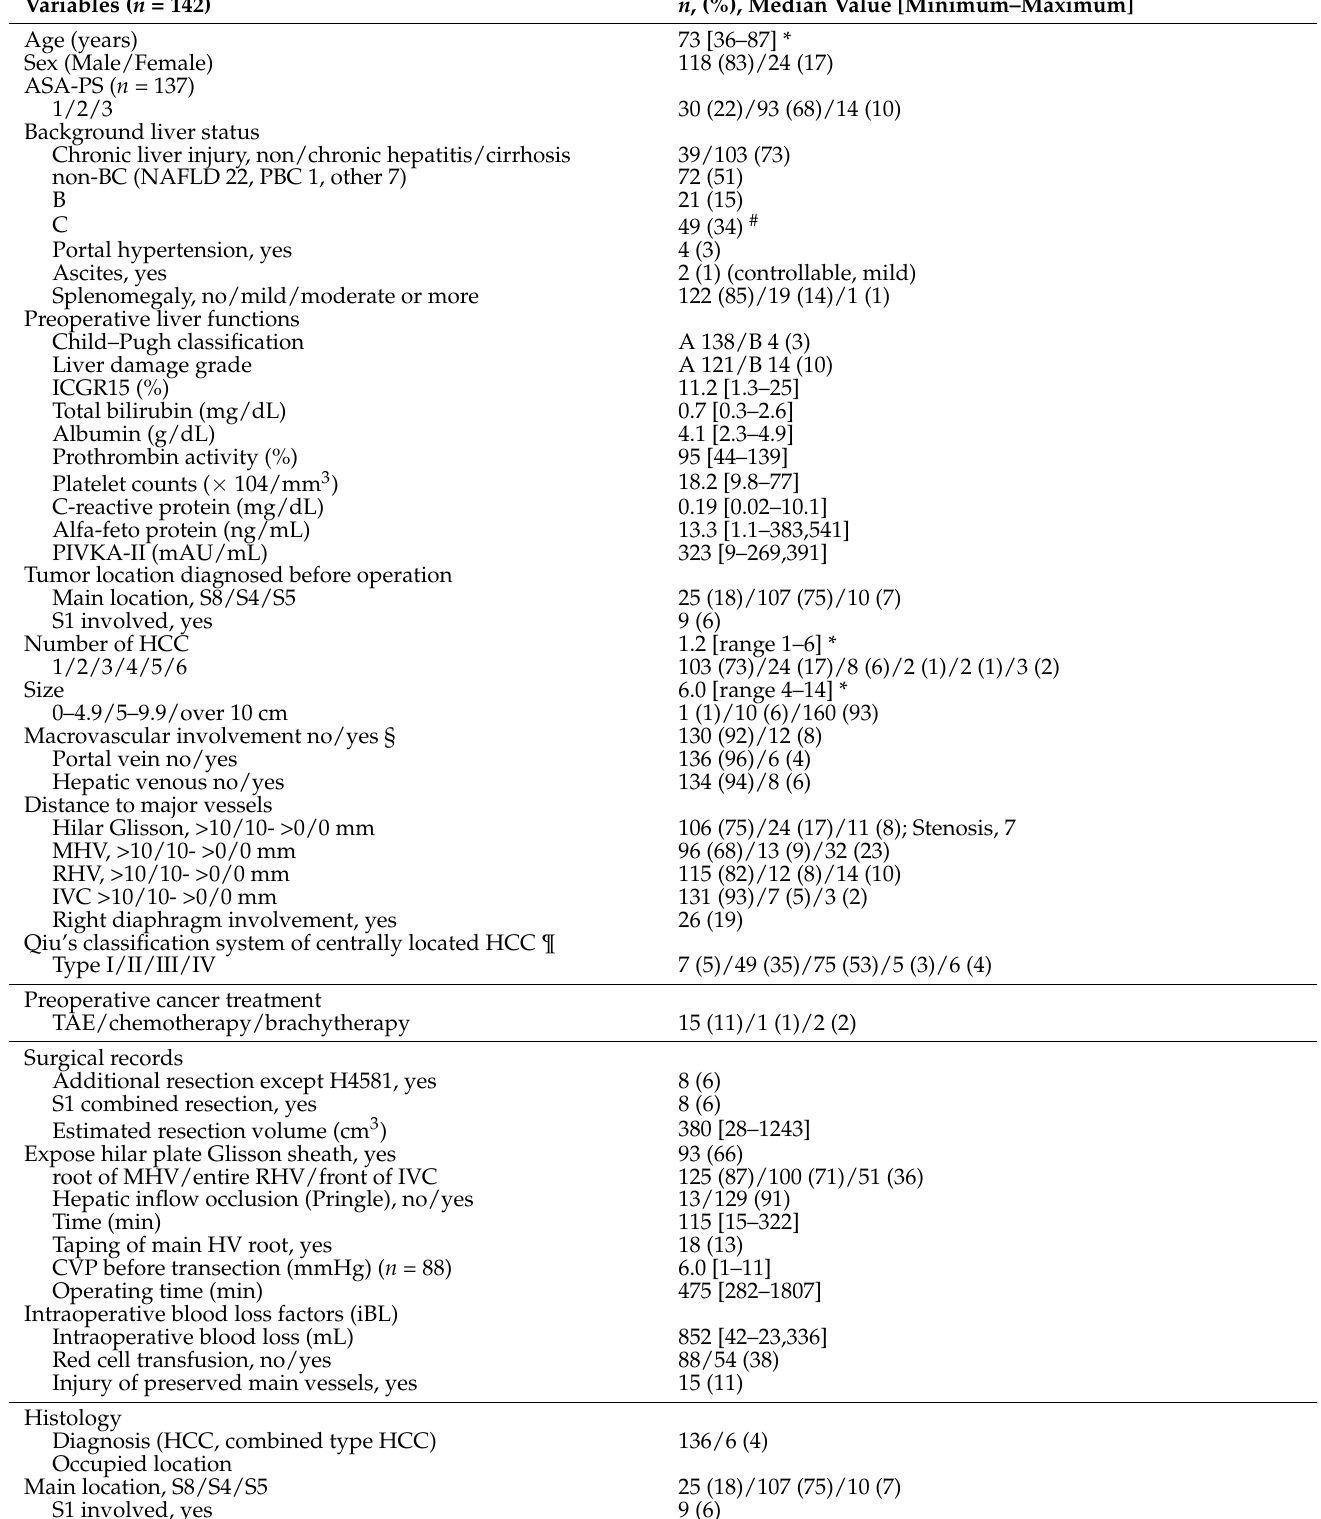
Table 1. Clinical, laboratory, radiological, and pathological characteristics of all subjects who under- went central bisectionectomy